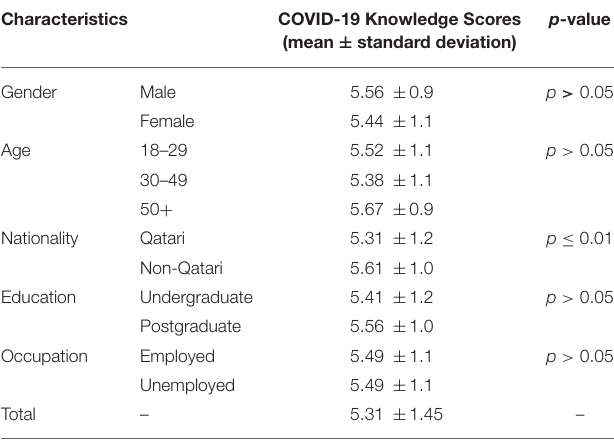
TABLE 2 | Coronavirus disease 2019 knowledge scores by demographic variables.